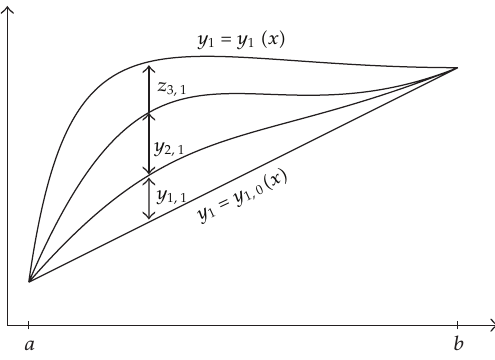
Figure 4: Geometric representation of the functions z 3 , 1